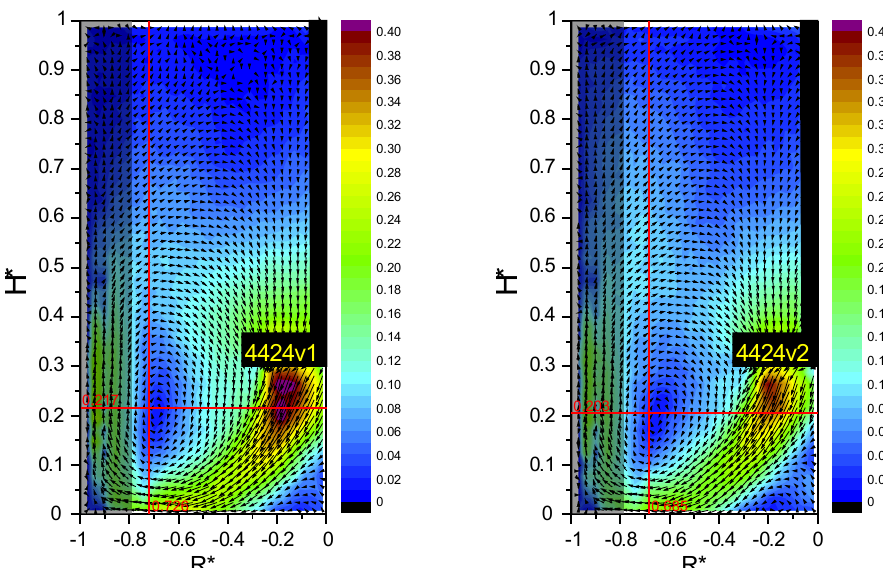
Figure 9. Dimensionless velocity maps for N = 240 min − 1 in the axial–radial plane.